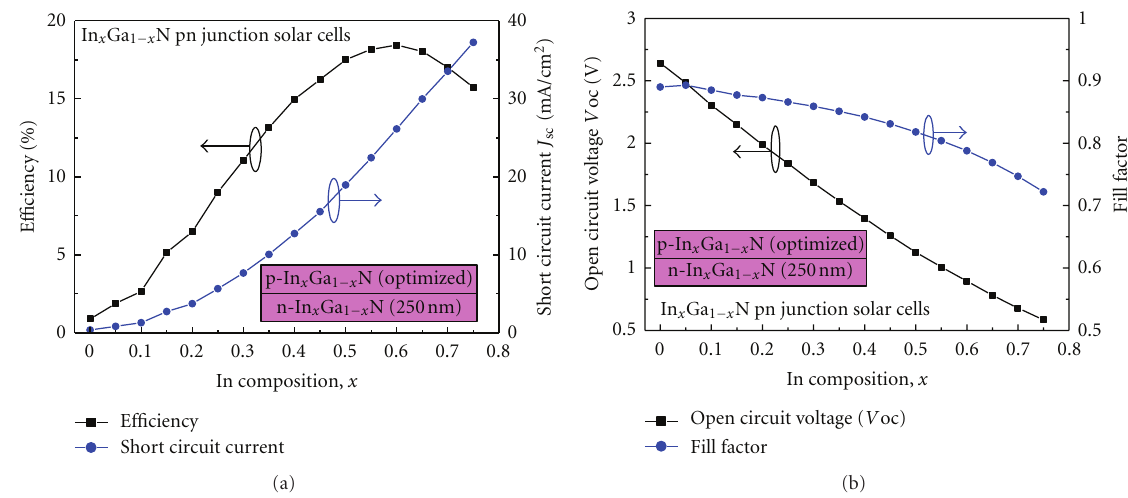
Figure 1: (a) The e ffi ciency and short circuit current ( J sc ) as well as (b) open circuit voltage ( V oc ) and fill factor of In x Ga 1 − x N pn junction solar cells, respectively, with an In composition from x = 0 ( E g = 3 . 4eV) to x = 0 . 75 ( E g = 1 . 11 eV) under AM1.5 illumination. The inset shows the structure of In x Ga 1 − x N pn junction solar cells.